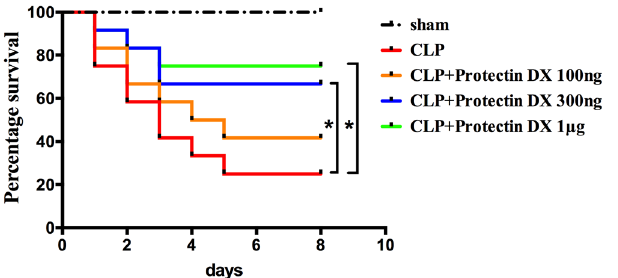
Figure 1. PDX reduced mortality of mice after CLP. Kaplan–Meier survival curves were used to estimate survival rate in five groups. Survival rate differences were analyzed by the log-rank test. An equal volume of vehicle was given in both the sham and CLP groups, mice treated with PDX (300 ng or 1000 ng) 1 h after CLP showed higher survival rate as compared with the CLP group (n = 12). * P <